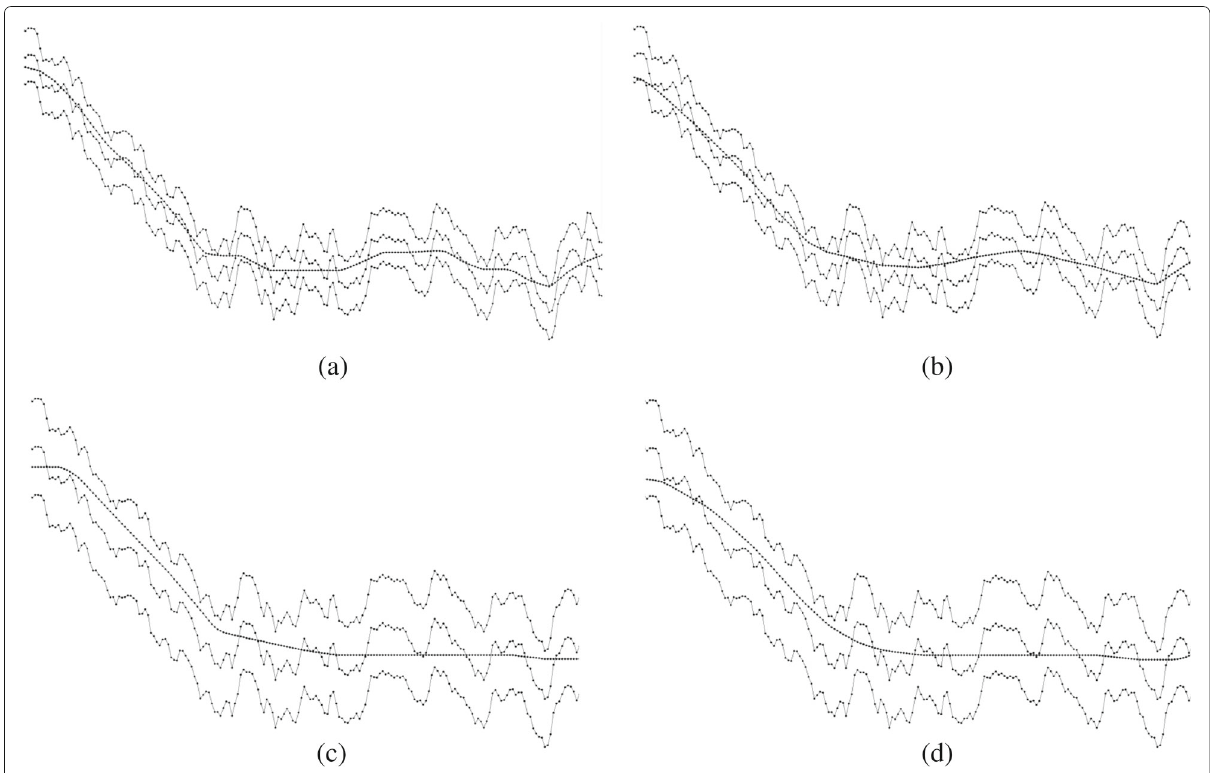
Fig. 14 Simulation results for a video including dynamic camera motion. a P 10,10% ( K = 10, image margin 10%), b P 20,%10 ( K = 20, image margin 10%), c